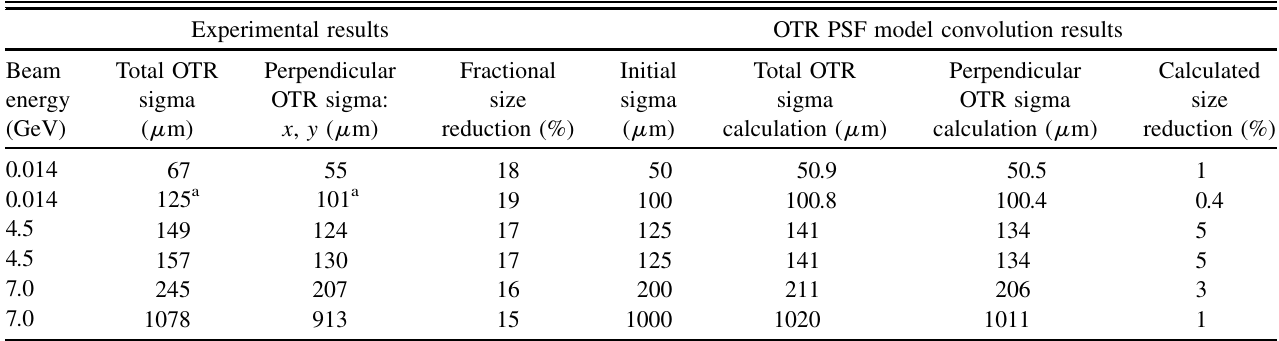
TABLE V. Summary of results from the three series of experiments ordered by increasing total OTR image sigma size. The fractional reductions obtained with the perpendicular component compared to the total OTR are 3–10 times larger in these experimental cases in column 4 than in the calculated OTR PSF convolution cases in column